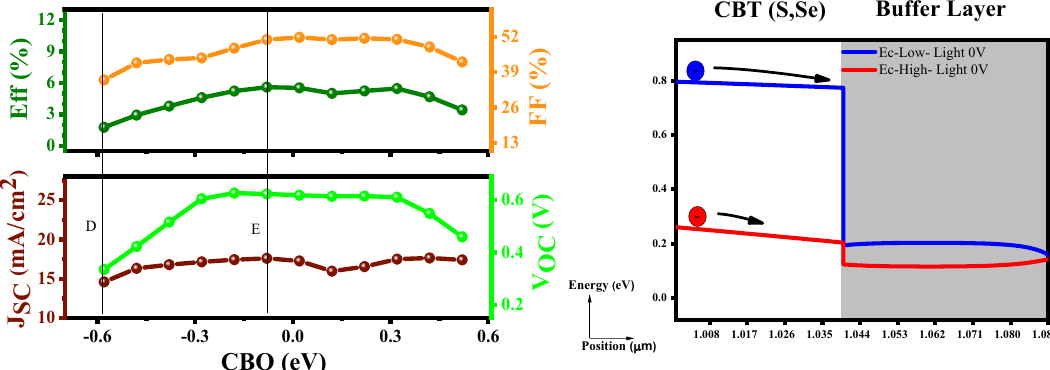
Figure 7. Variation of the solar cell parameters of the CBT (S, Se) solar cells with different CBO of the In 2 S 3 layer.